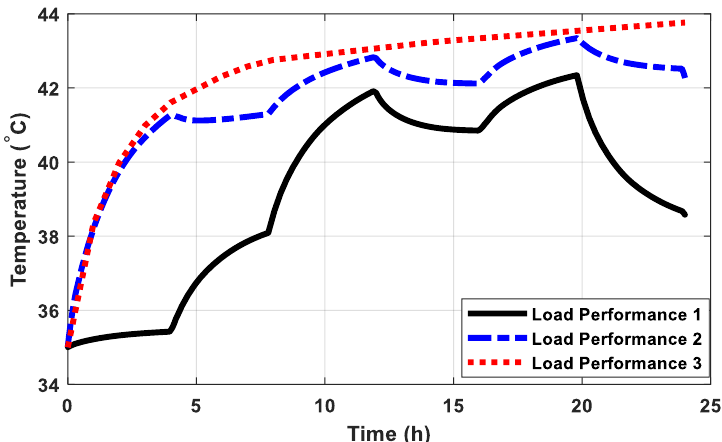
Figure 14. The cable and sheath temperatures variation through different daily load cycle.